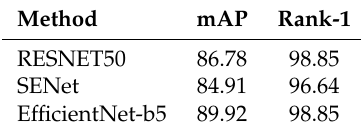
Table 4. Performance of the three tested architectures on boat Re-id dataset in terms of mAP and